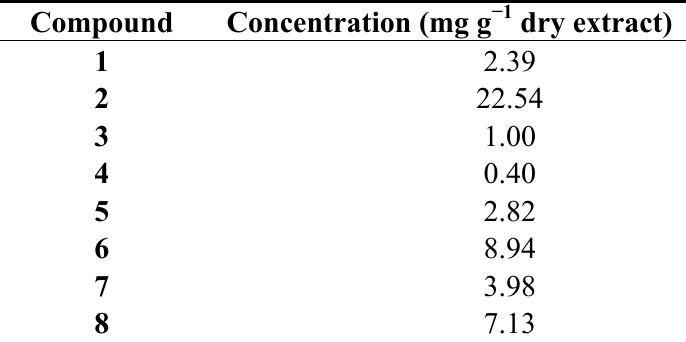
Table 1. Quantitative data for extracts of